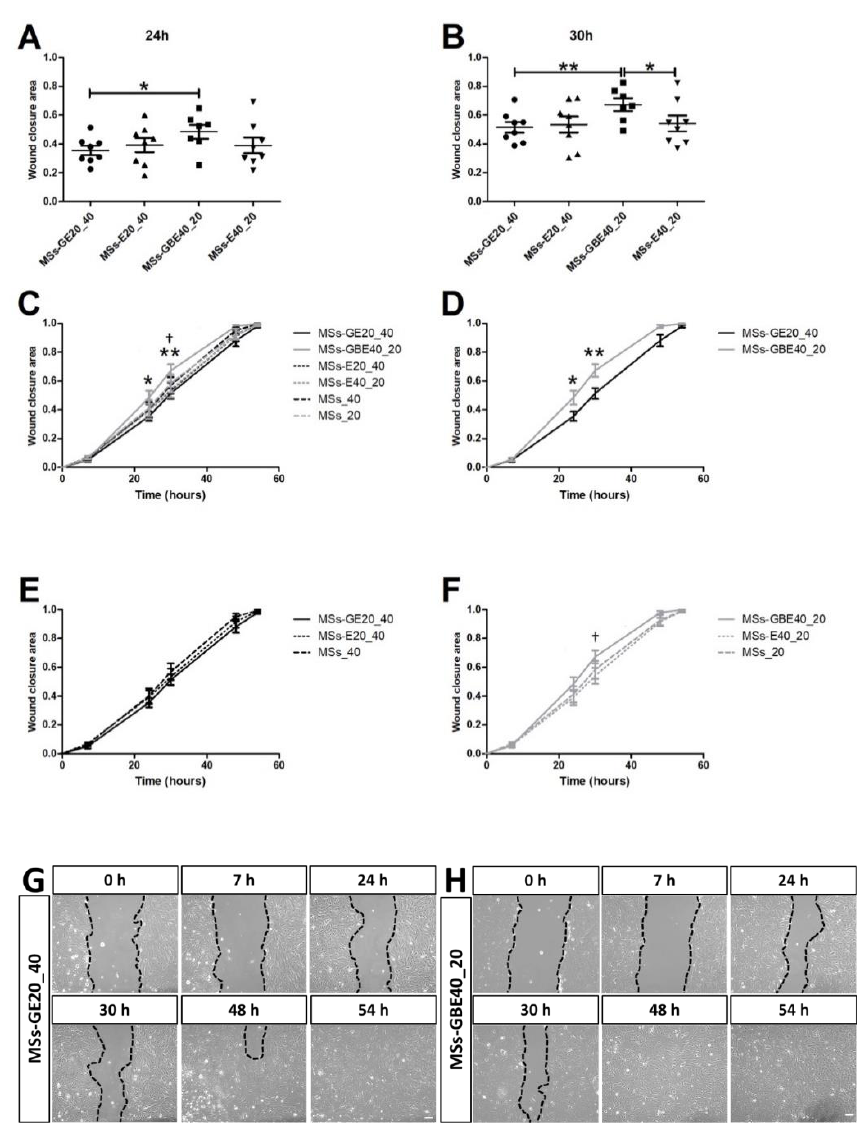
Figure 4. Wound closure area in ARPE-19 cells. MSs-GBE ( − ) treated cells showed a more closed wound area than MSs-GE ( − ) treated cells both at 24 h ( A ) and 30 h ( B ) from scratch ( p <0.05 and p < 0.01, respectively) and than MSs-E20_40 ( - - - ) at 30 h ( B , p < 0.05). Graphs ( C – F ) and representative images ( G , H ) show a different pattern in timeline migration between MSs-GBE and MSs-GE treated groups in ARPE-19 cells at 0, 7, 24, 30, 48 and 54 h after scratching. Black dotted lines indicate the wound borders at the different time points and treatments. Blank MSs (MSs_20) and (MSs_40); GDNF/VitE(20)-loaded PLGA MSs (MSs-GE20_40); GDNF/BDNF/VitE(40)-loaded PLGA microspheres (MSs-GBE40_20). Scale bar: 100 µm. n = 6–8. * p < 0.05 and ** p < 0.01 MSs-GBE vs. MSs-GE; † p < 0.05 MSs-GBE vs. MSs-E40_20.